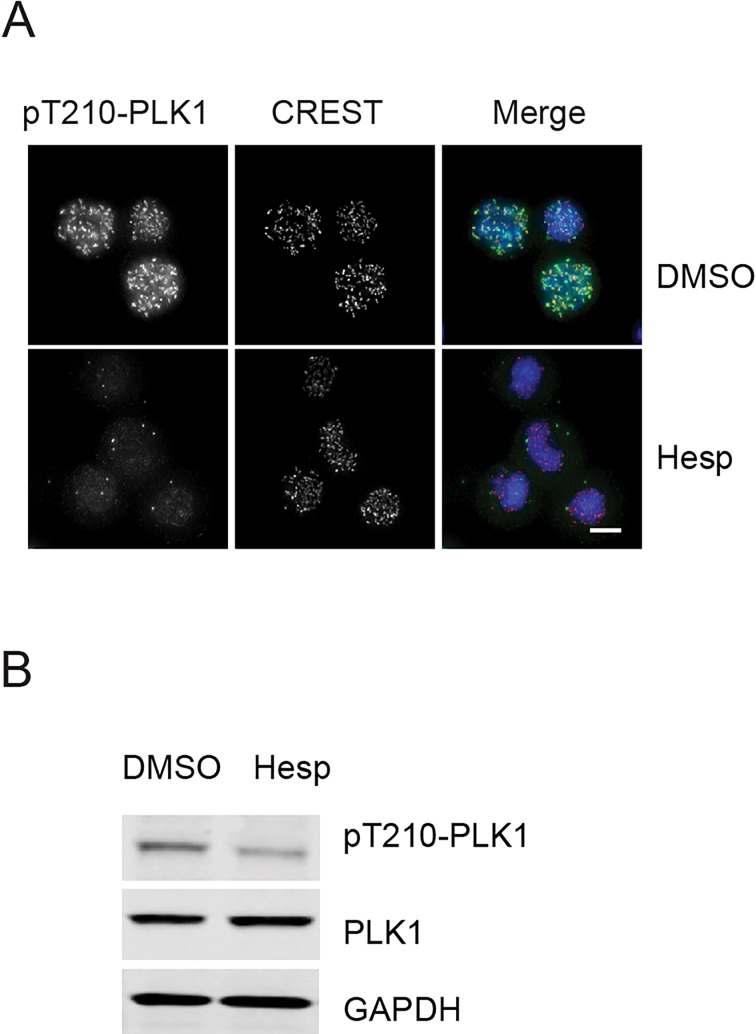
Aurora B inhibitor reduces pT210-PLK1 levels. (A) Cells were treated as in Fig. 3A and stained with pT210-PLK1 (green), CREST (red) and DAPI (blue). Scale bar 10 μm. (B) Cells were treated as in Fig. 3E and proteins were analysed by western blot with the indicated antibodies.